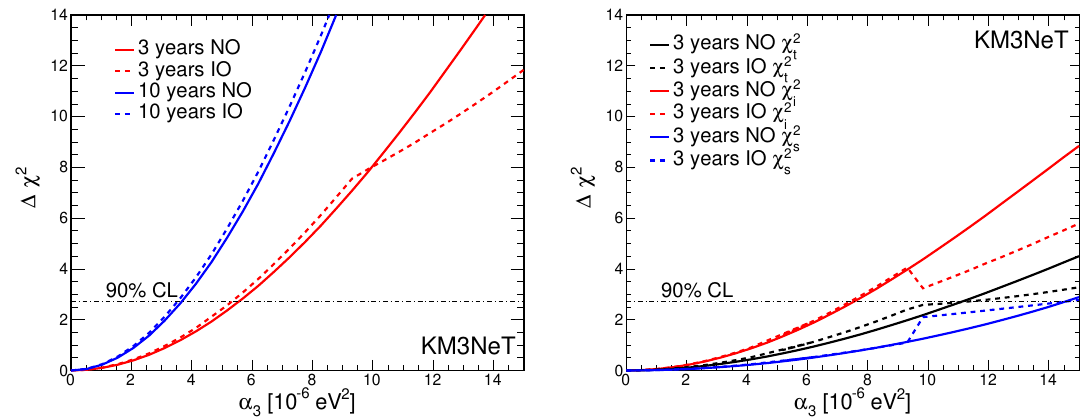
Figure 5. Left: Sensitivity to invisible neutrino decay for 3 (red) and 10 (blue) years of data taking in KM3NeT/ORCA assuming NO (solid lines) and IO (dashed lines) as a function of α 3 in the model. Right: Sensitivity to invisible neutrino decay assuming NO (solid lines) and IO (dashed lines) for 3 years of data taking as a function of α 3 in the model per topology: χ 2 for track events t (black), χ 2 for intermediate events (red), χ 2 for shower events s i